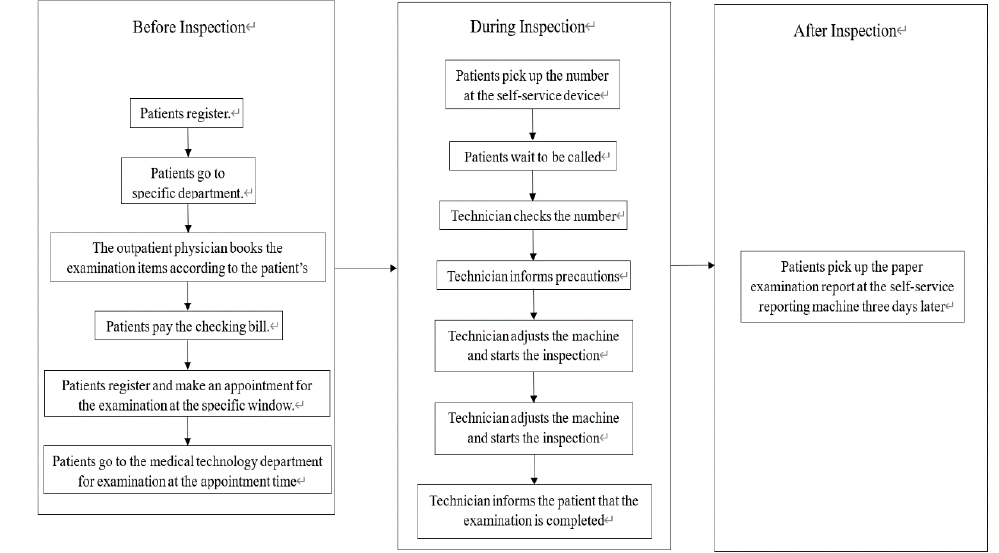
Figure 2. The flowchart of inspection. Table 1. List of FMs across the medical examination process in the targeted hospital.